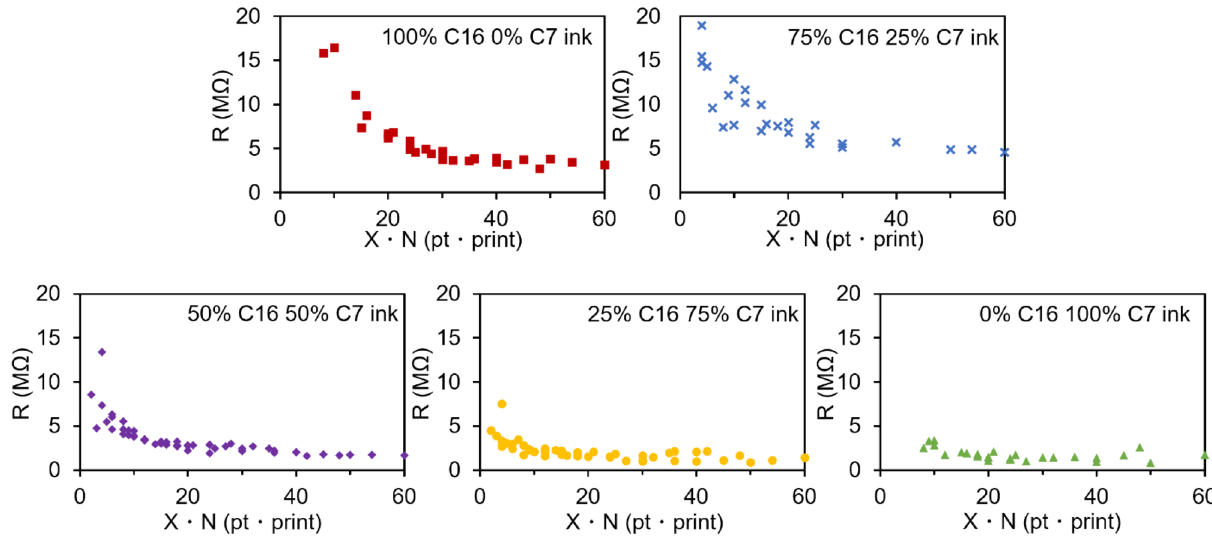
Figure 4. The resistance of printed lines on paper prepared with inks of varying proportions of C7 and C16. Resistance is plotted as a function of the product of line width (X) and the number of prints (N).